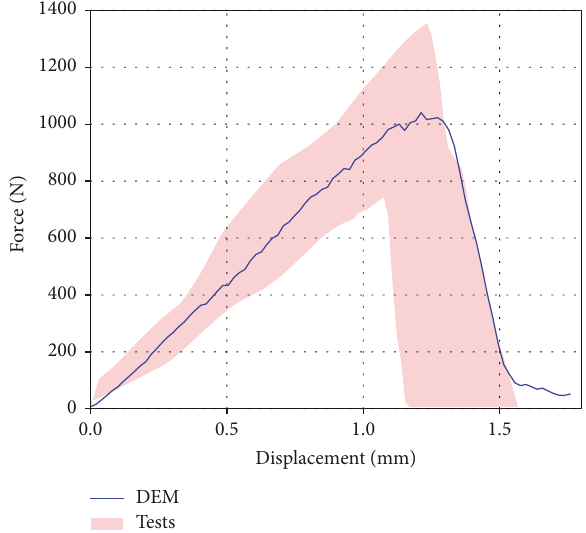
Figure 12: Comparison between experimental and numerical (prin- cipal stress criterion) results in dynamic